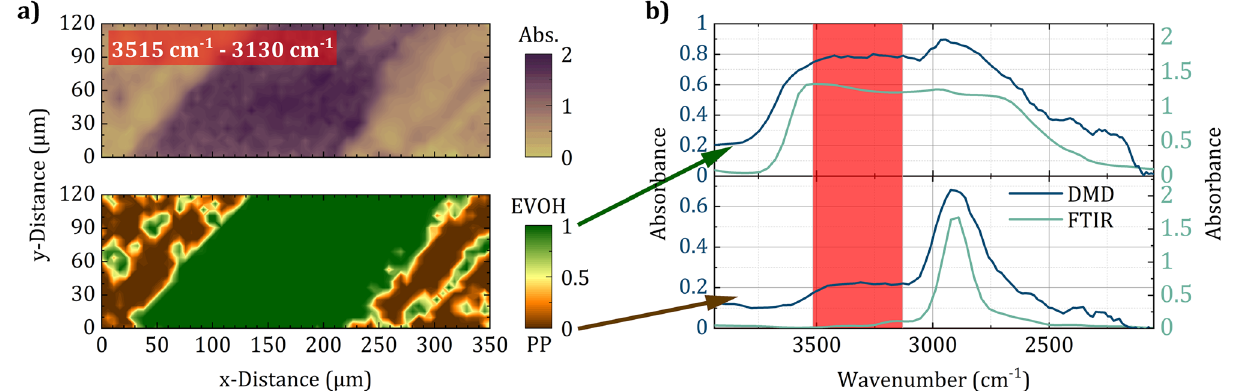
Figure 6. ( a ) Absorbance image of PP/EVOH/PP multilayer film calculated by averaging the spectral band 1 1 from 3515 cm − to 3130 cm − (OH stretching bond, top), and probability estimates for EVOH and PP calculated by means of logistic regression (bottom). ( b ) Global EVOH and PP spectra (blue) resulting from weighing the spectra in each spatial channel according to the respective probability, and a comparison to conventional FTIR spectra of pure EVOH and PP (turquoise) also recorded in reflection configuration. The characteristic absorption band used for averaging in the top section of (a) is indicated